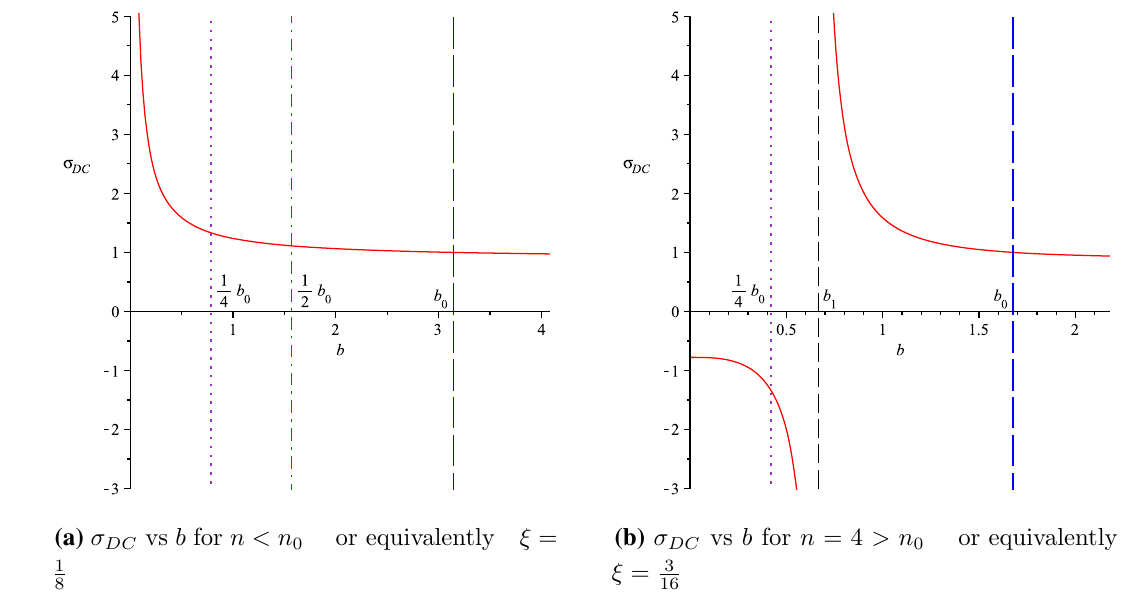
Fig. 1 The conductivity σ DC in term of the parameter b for nonminimal couplings 0 < ξ < 1